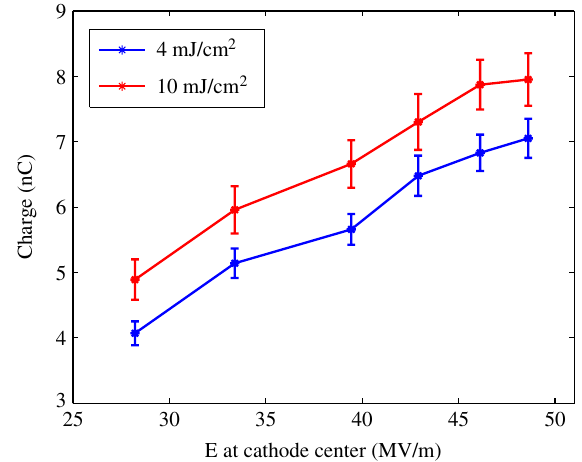
FIG. 5. Captured charge measured at the exit of the rf gun as a function of electric field at the cathode center for two different average laser input energy intensities.